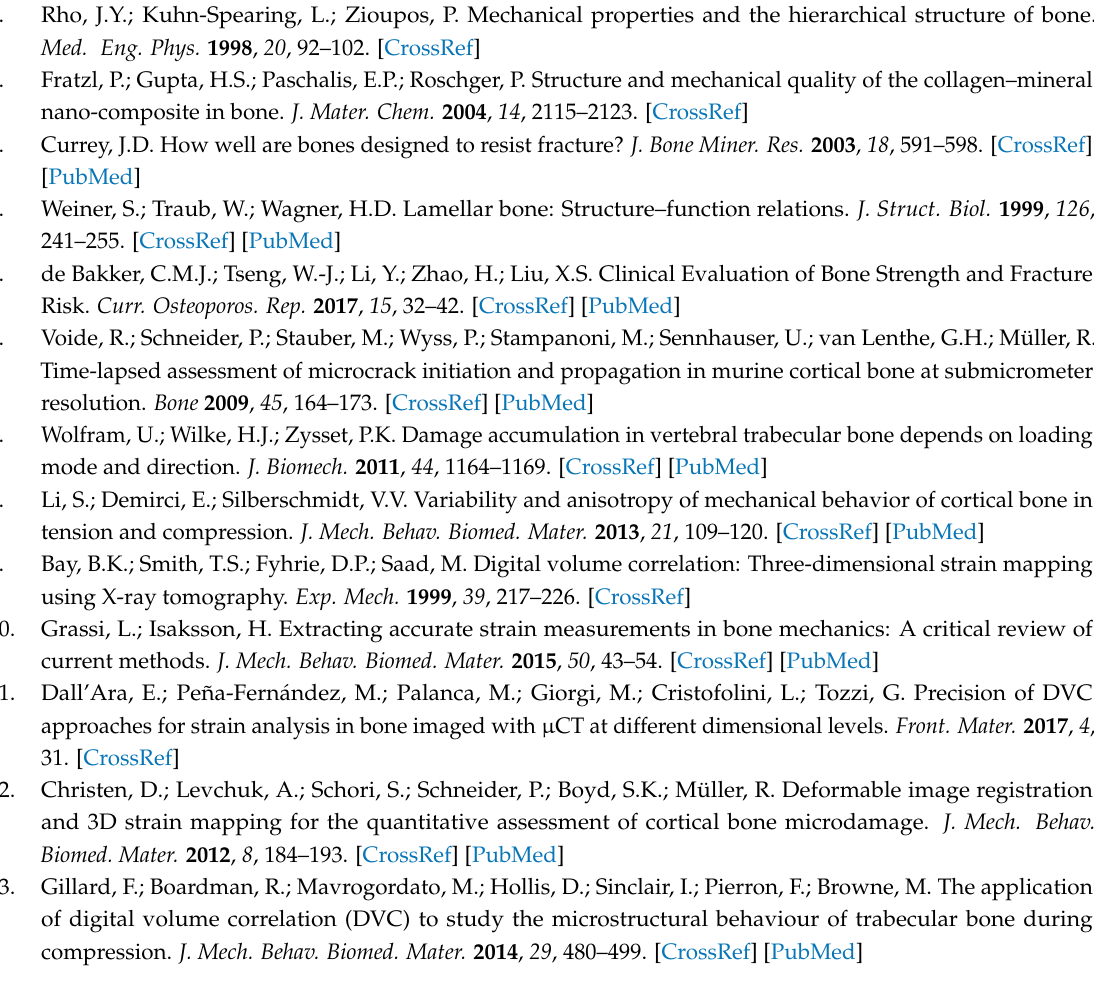
s1, Figure S1: Relationship between ( a ) MAER and ( b ) SDER with the sub-volume size for the four bone specimens, Figure S2: Histograms of the residual strain distribution in compact bone tissue imaged at room temperature (top) and 0 ◦ C (bottom). ( a ) Third principal strains ( ε p3 ) and ( b ) maximum shear strains ( γ max ) after each acquired tomogram are shown, Table S1: Random errors for the three displacement components for compact and trabecular bone specimens. Median values of the two specimens per group are